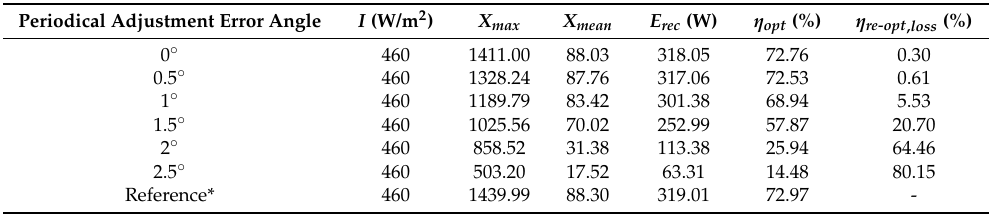
Table 4. Experimental optical characteristics of the fixed-focus Fresnel lens solar concentrator under different periodical adjustment error